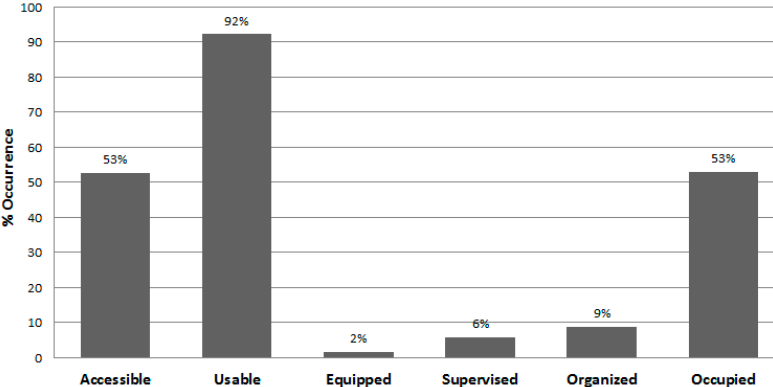
Figure 6. Observed park area characteristics ( n = 8384 area visits).